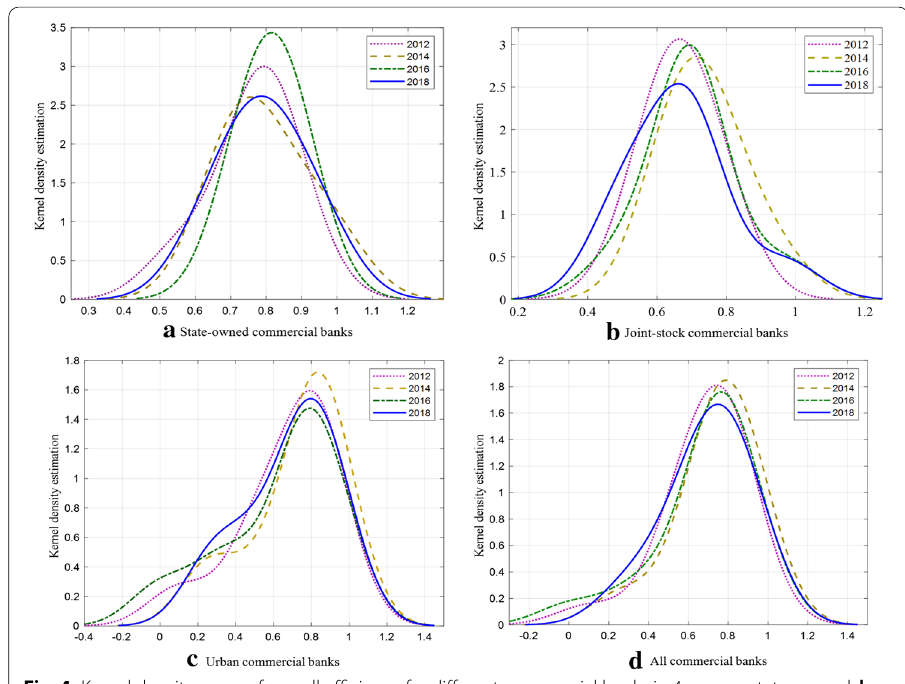
Fig. 4 Kernel density curve of overall efficiency for different commercial banks in 4 years. a state‑owned; b joint‑stock; c urban; d all